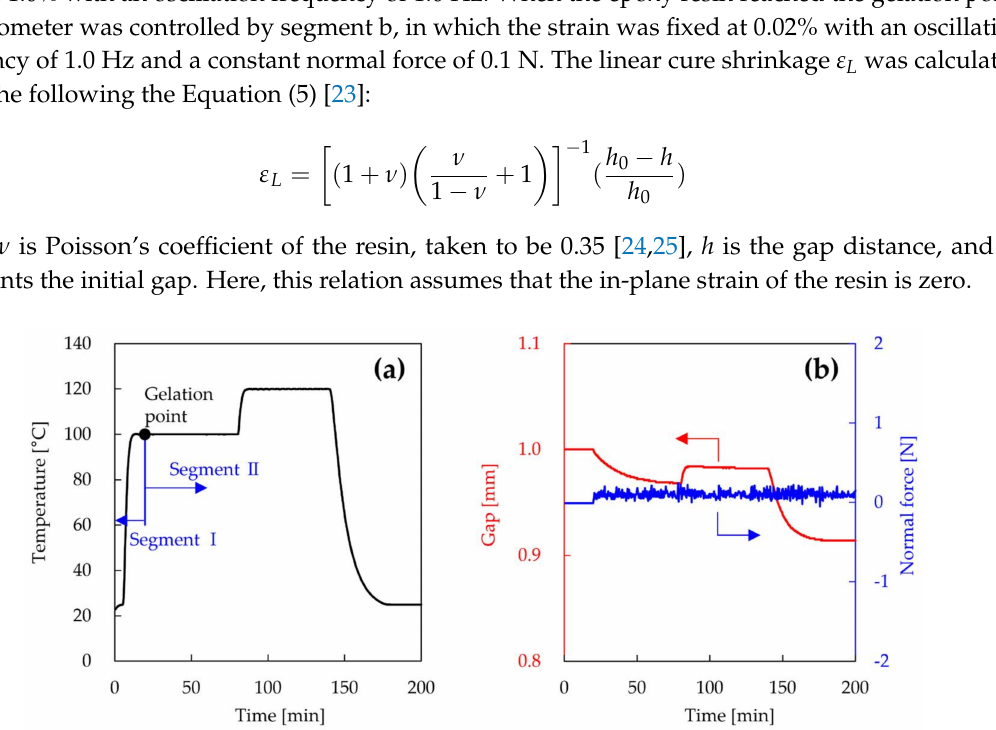
Figure 1. Temperature profile ( a ); gap and normal force ( b ) of epoxy resin at 100 ◦ C setting